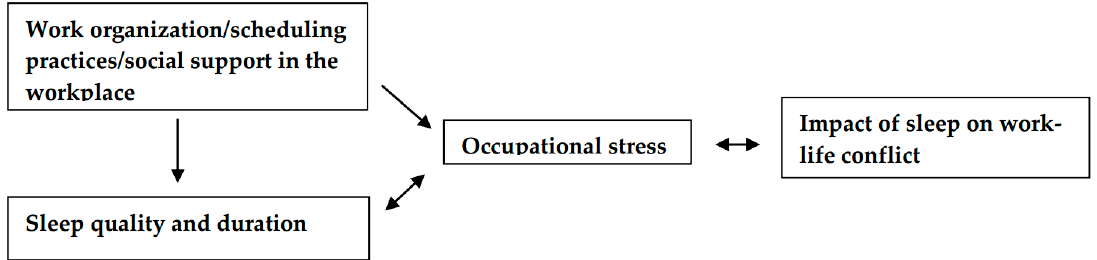
Figure 1. Hypotheses for relationships between work organization/scheduling, sleep, stress, and work-life conflict among LHTDs.